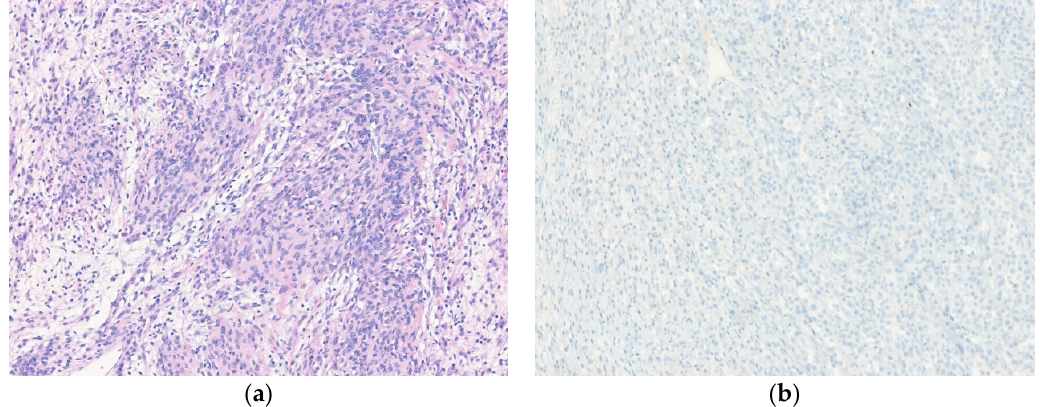
Figure 8. Malignant peripheral nerve sheath tumor. ( a ) The tumor is composed of spindle cells with alternating hypercellular and hypocellular areas. ( b ) The tumor cells show loss of H3K27me3 expression (H&E stain, original magnification 100× a ; H3K27me3 immunostain, original magnification 200× b ).